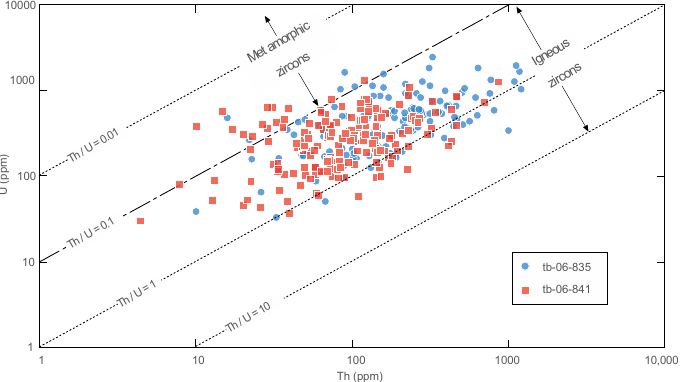
Minerals 2023 , 13 , x FOR PEER REVIEW Figure 3. Th/U vs. 206 Pb/ 238 U age (Ma) of analyzed zircons of Ojén nappe’s quar tz ites. Figure 3. Th/U vs. 206 Pb/ 238 U age (Ma) of analyzed zircons of Oj é n nappe’s quartzites.